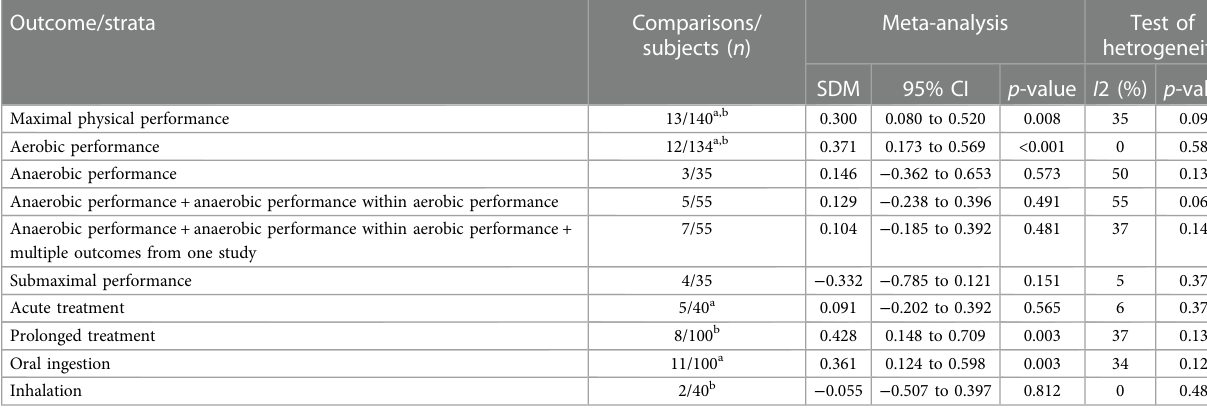
TABLE 3 Meta-analysis for the effect of glucocorticoids on various pysicical performance outcomes and maximal performance strati fi ed by duration of treatment and route of administration.